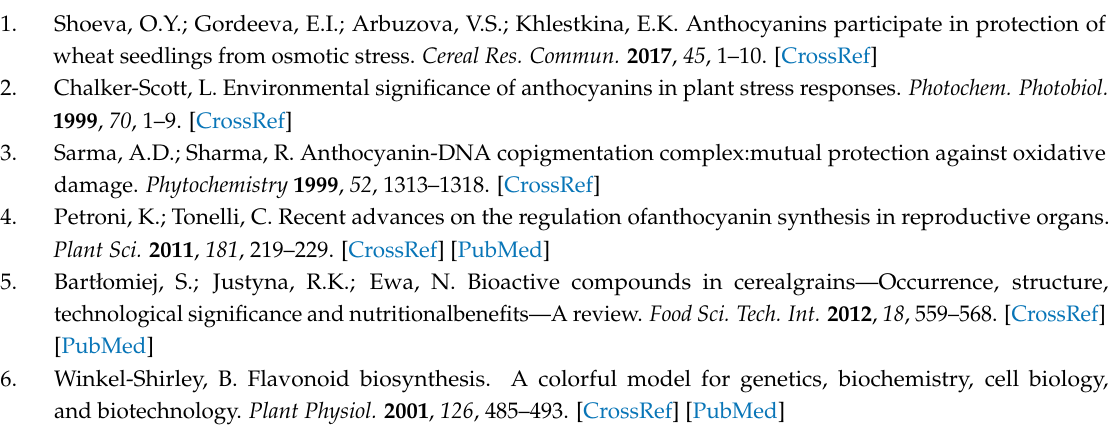
Table S2. Summary of sequencing data; Table S3. The annotation summary of predicted protein numbers from various databases; Table S4. Information on unigenes associated with anthocyanin biosynthesis in coleoptiles. Author Contributions: B.L. and H.Z. conceived and designed the experiments. D.C. and J.F. coordinated and performed the experiments. X.X., Y.Z., and D.W. analyzed the data. D.C. and B.L. wrote the paper. All